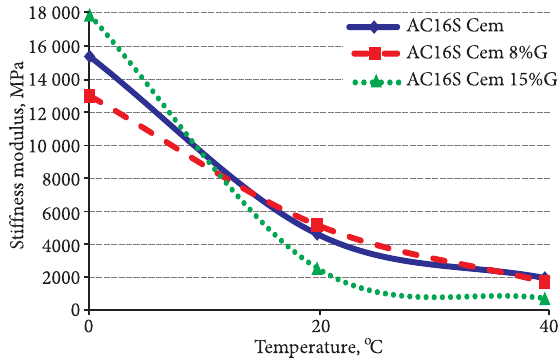
Fig. 2. Variation of the stiffness modulus of the cement samples with